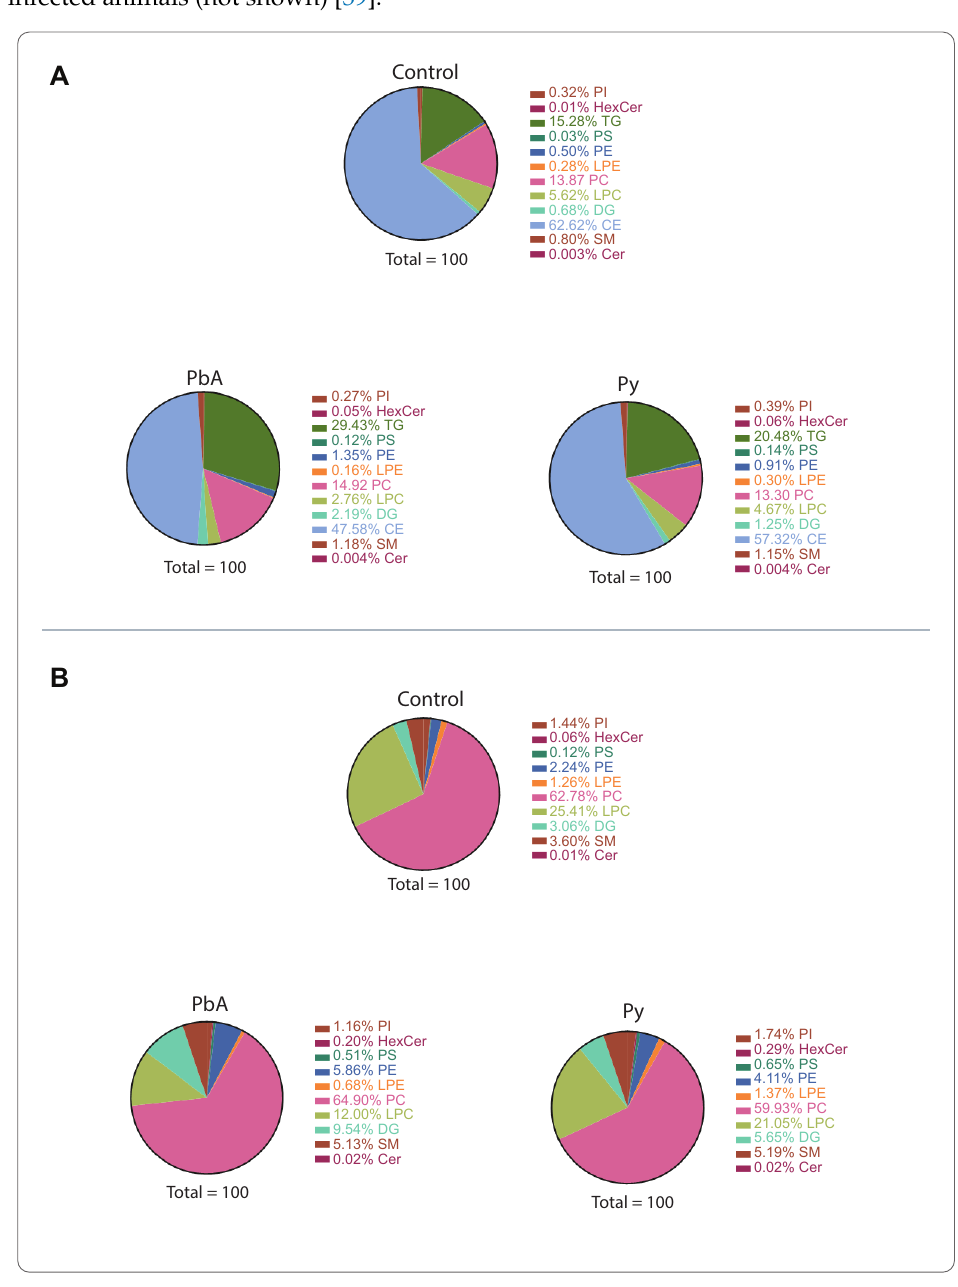
Figure 1. Lipid classes in plasma microvesicles (MV) from uninfected controls, PbA-infected and Py- infected mice. ( A ) All lipid classes. ( B ) Levels without triglycerides (TG) and cholesteryl esters